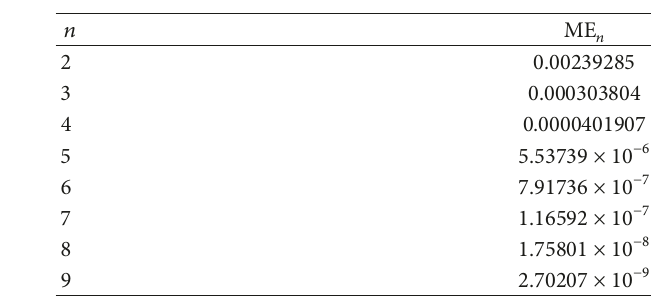
Table 1: For 𝑐 = 0.1 and 𝛼 = 2 , maximal errors ME 𝑛 for 𝑛 = 2, 3, ...,9 obtained by the Duan-Rach modified